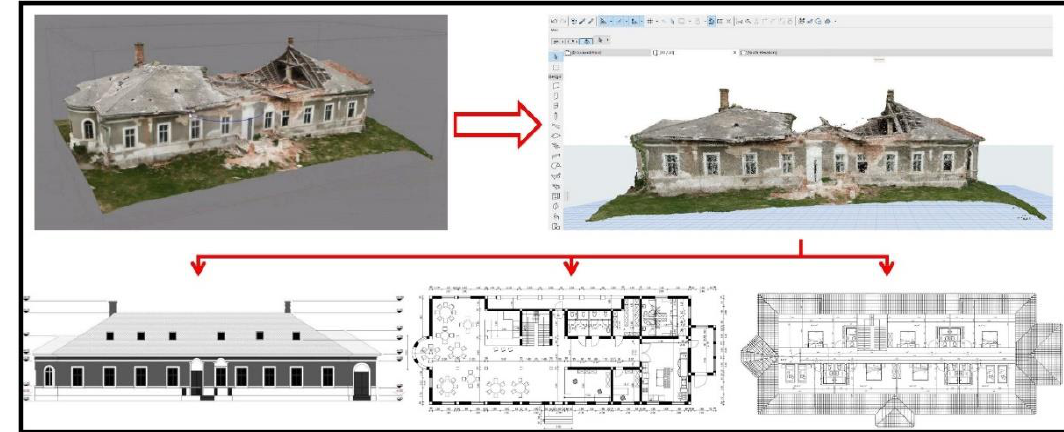
Figure 9. SfM 3D model export in architectural software.